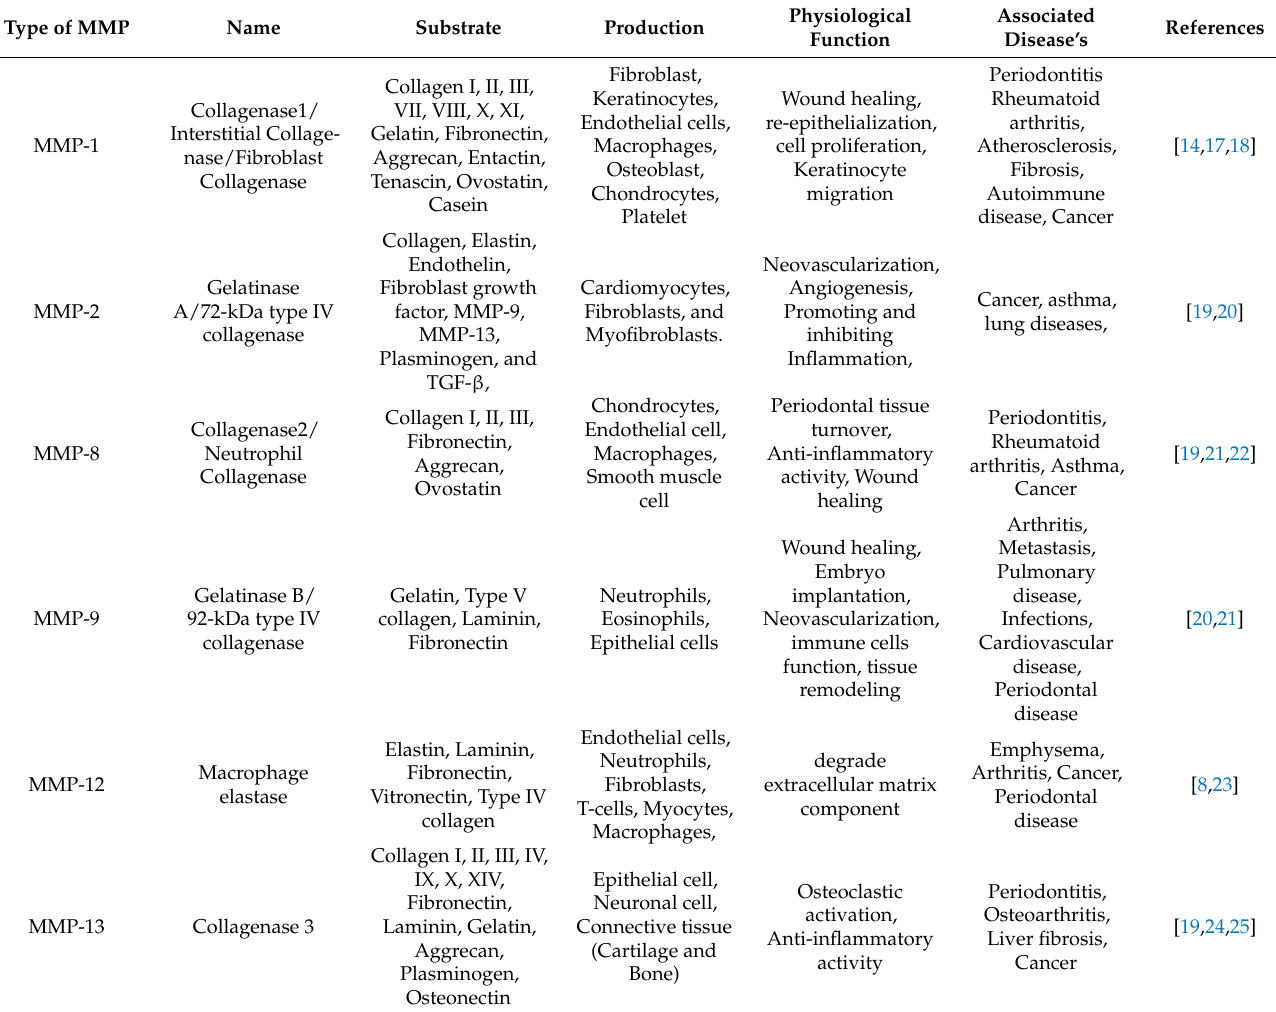
Table 1. The main metalloproteinases: name, substrates, and the main diseases in which they are